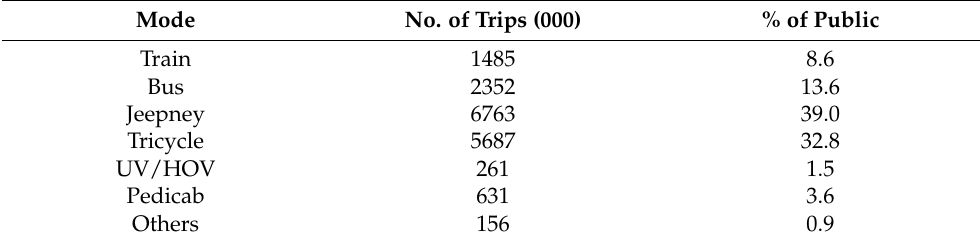
Table 3. Metro Manila travel demand by